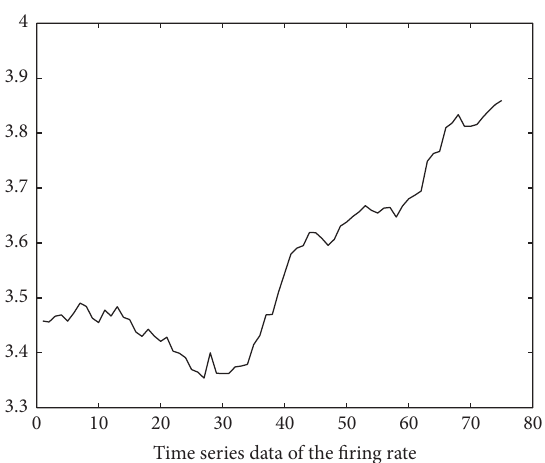
Figure 16: Firing rate series of ValidateUserMail.